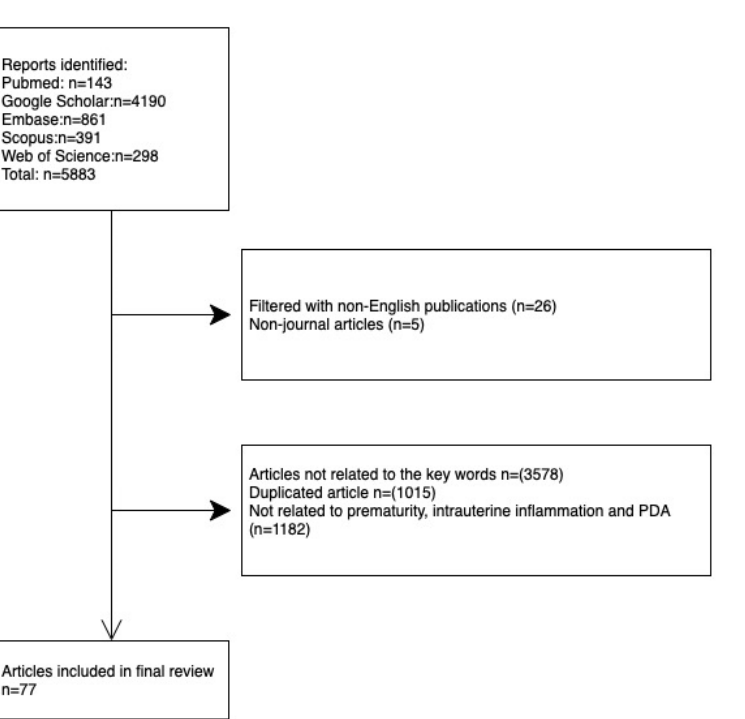
Figure 1. A PRISMA flow diagram of searching strategy of relevant articles.